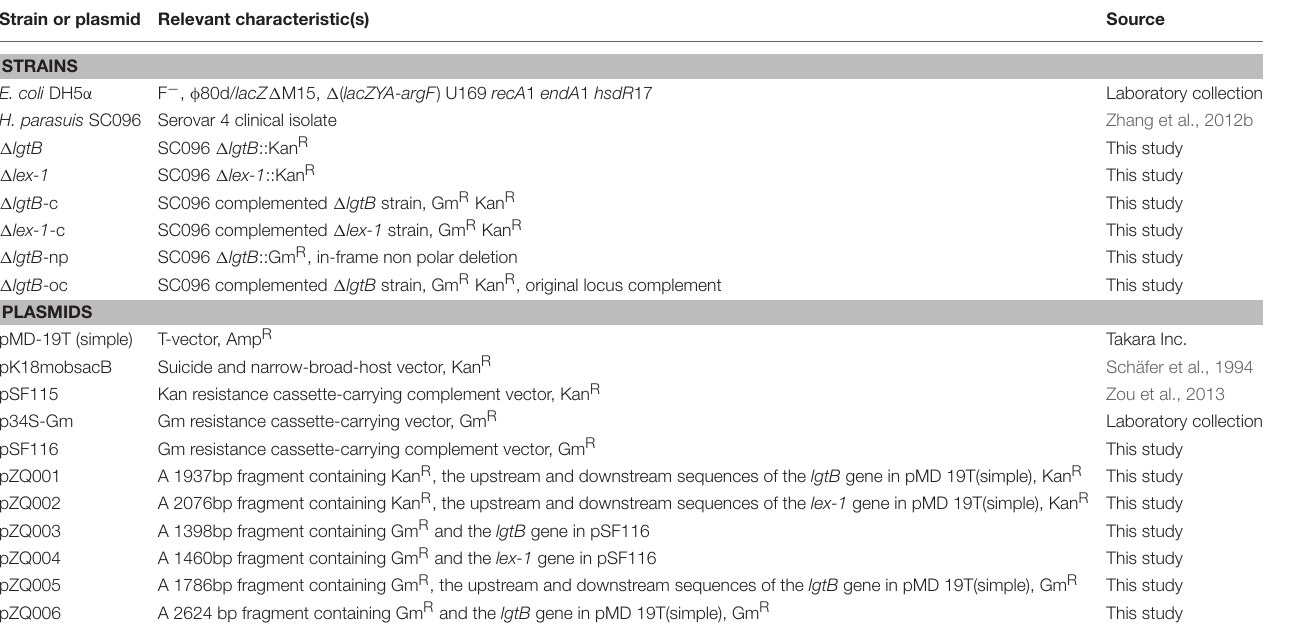
TABLE 1 | Bacterial strains and plasmids used in this study. Strain or plasmid Relevant characteristic(s) Source